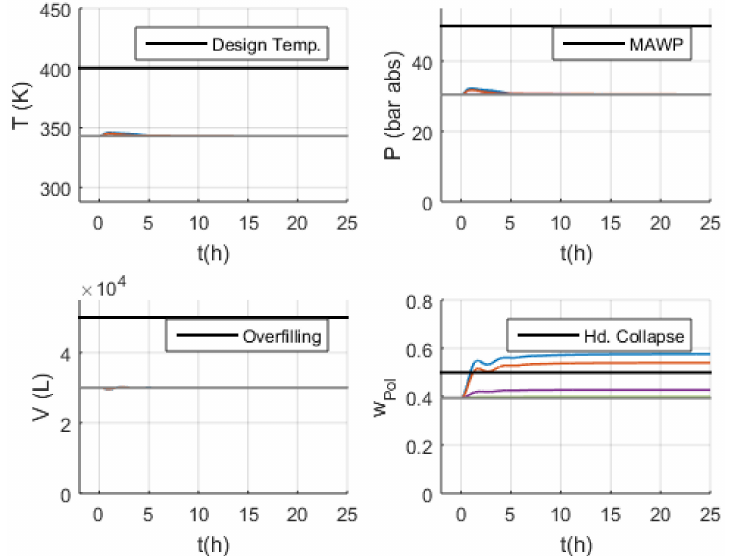
Figure 25. Behavior of critical variables in scenario S-18 with Model 2. Inlet catalyst flowrate: ( ) maximum flow; ( ) 150% of normal flow; ( ) 110% of normal flow; ( ) 101% of normal flow; ( )